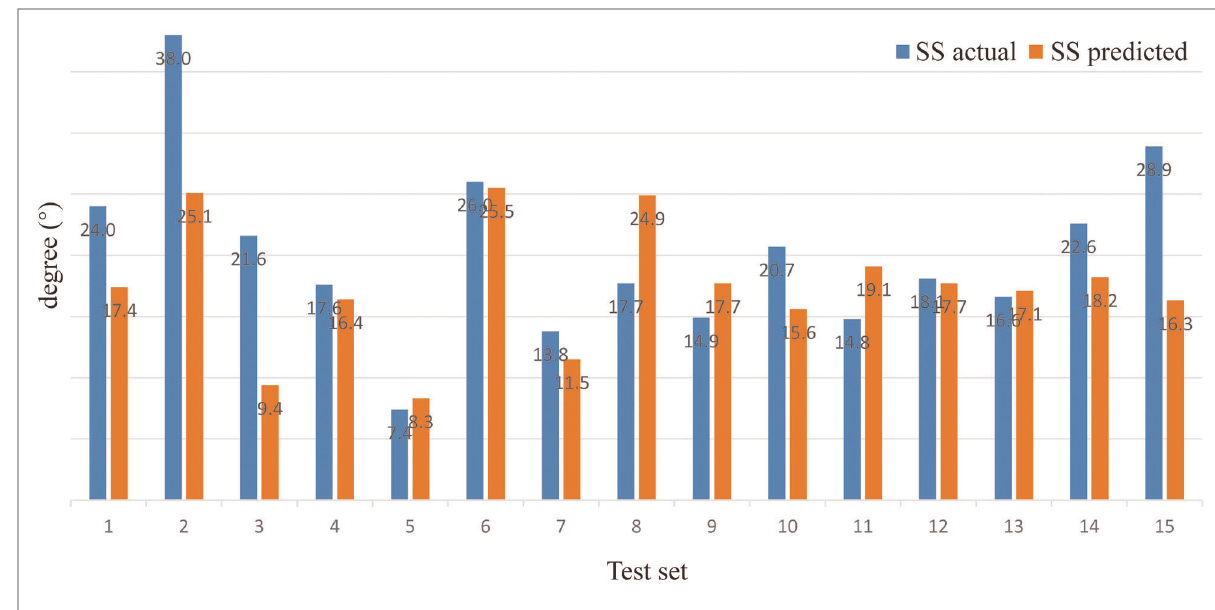
FIGURE 4 Comparison between the actual and the predicted values of sitting SS.